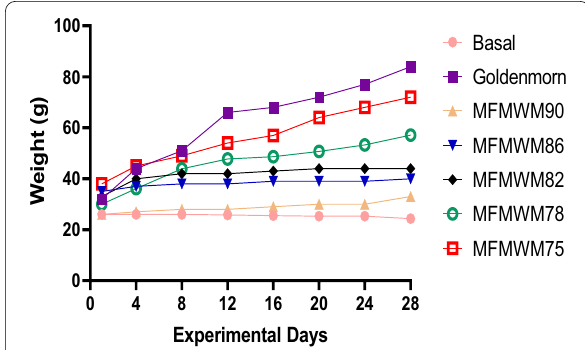
Fig. 1 Weight-for-days of the experimental animal. Key: Basal (animal chow); Goldenmorn (commercial control breakfast meal); MFMWM90: Malted finger millet:Watermelon seeds (90.00:10.00%); MFMWM86: Malted finger millet:Watermelon seeds (86.25:13.75%); MFMWM82: Malted finger millet:Watermelon seeds (82.50:17.50%); MFMWM78: Malted finger millet:Watermelon seeds (78.75:21.25%)